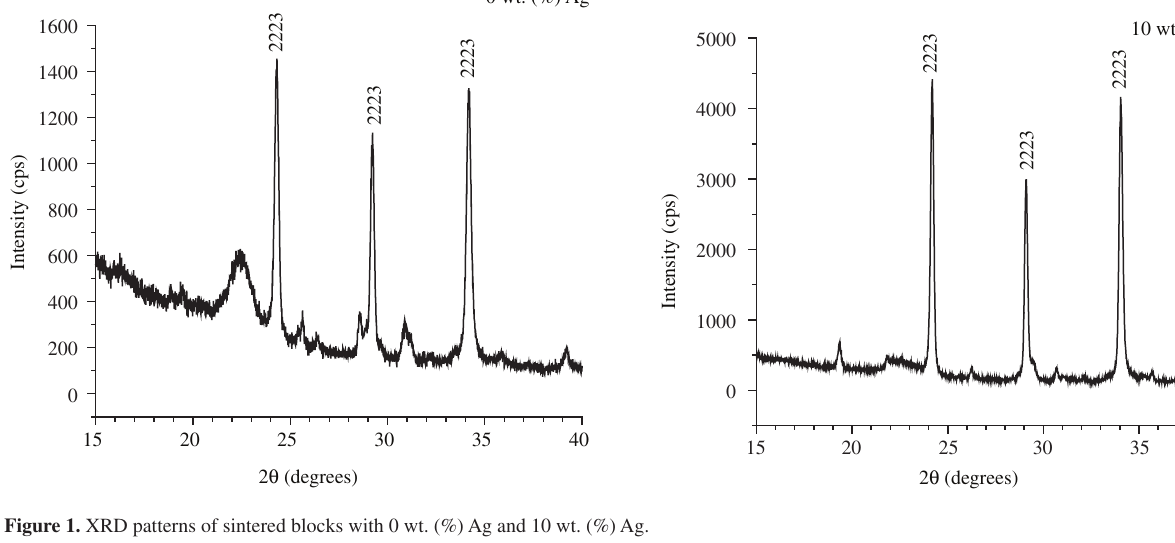
Figure 1. XRD patterns of sintered blocks with 0 wt. (%) Ag and 10 wt. (%) Ag.